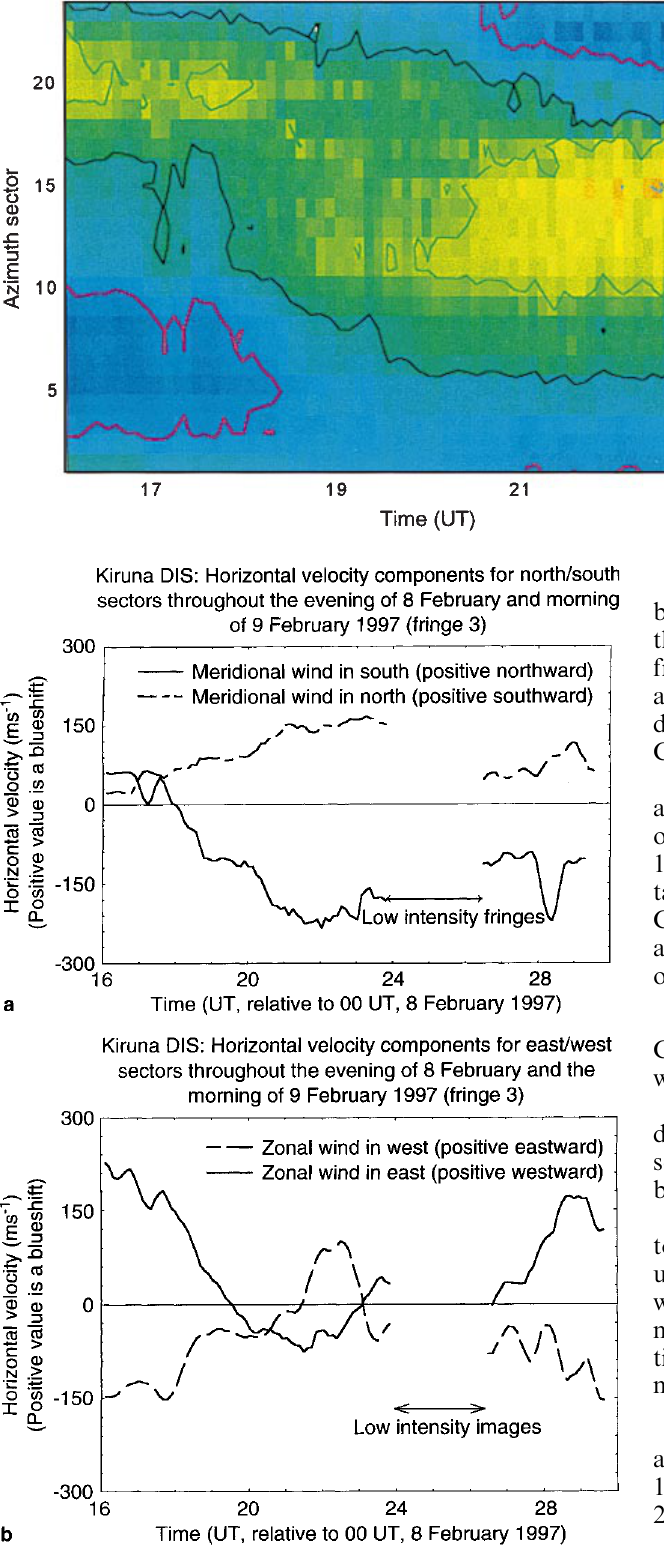
Fig. 8a, b. The horizontal winds corresponding to the individual a north and south and b west and east viewing directions, above Kiruna for the night of February 8/9 1997